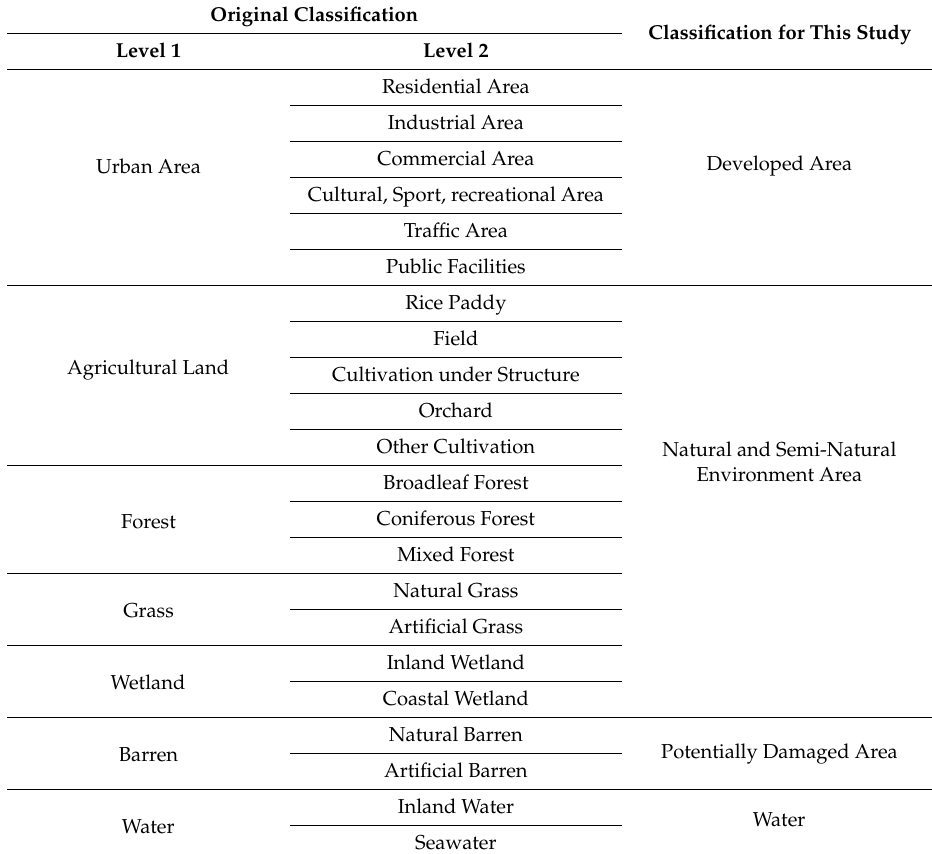
Table 1. Two-level hierarchy of land-cover categories in the 2004 and 2013 land-cover maps provided by the South Korean Ministry of Environment (“Original classification”) and the reclassified categories used in this study (“Classification for this